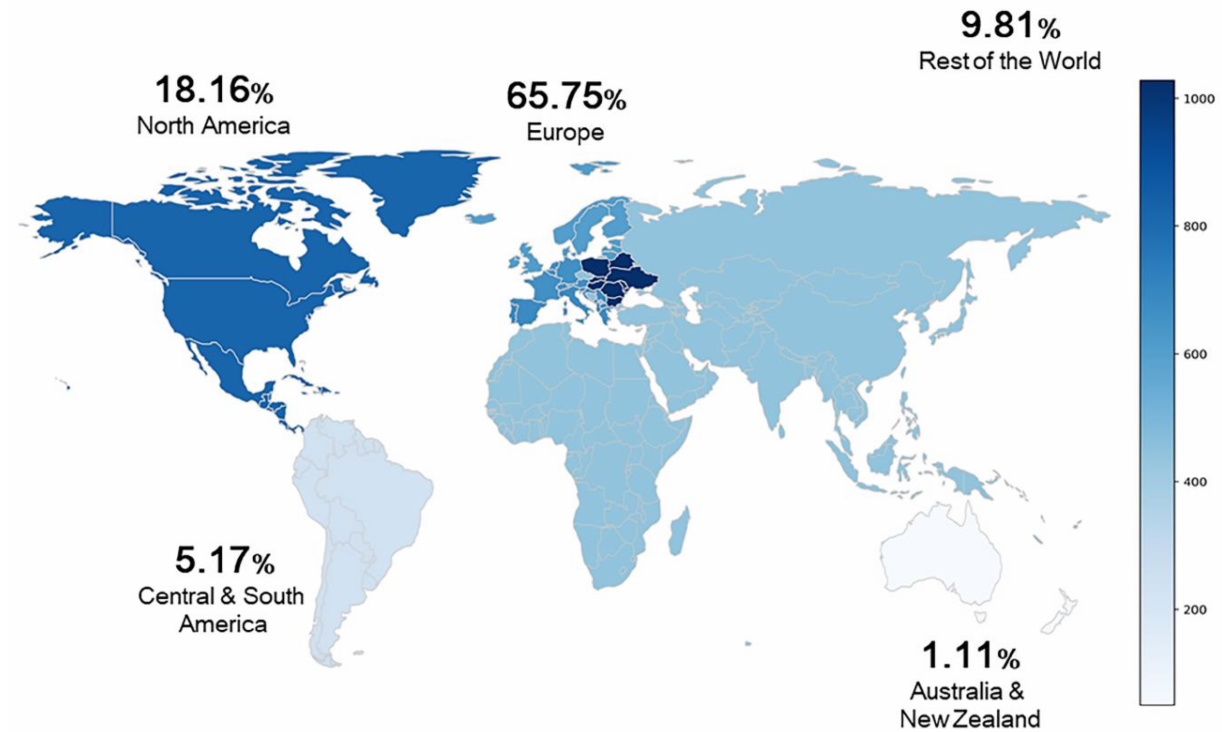
Figure 1. Global distribution of SMA patients who have registered under TREAT-NMD. The number of registries is rounded to two decimal places in percentage and Russia is included in the ‘Rest of the World’ herein. Data source: TREAT-NMD (https://treat-nmd.org/about-the-treat-nmd-network/ (accessed on 1 April